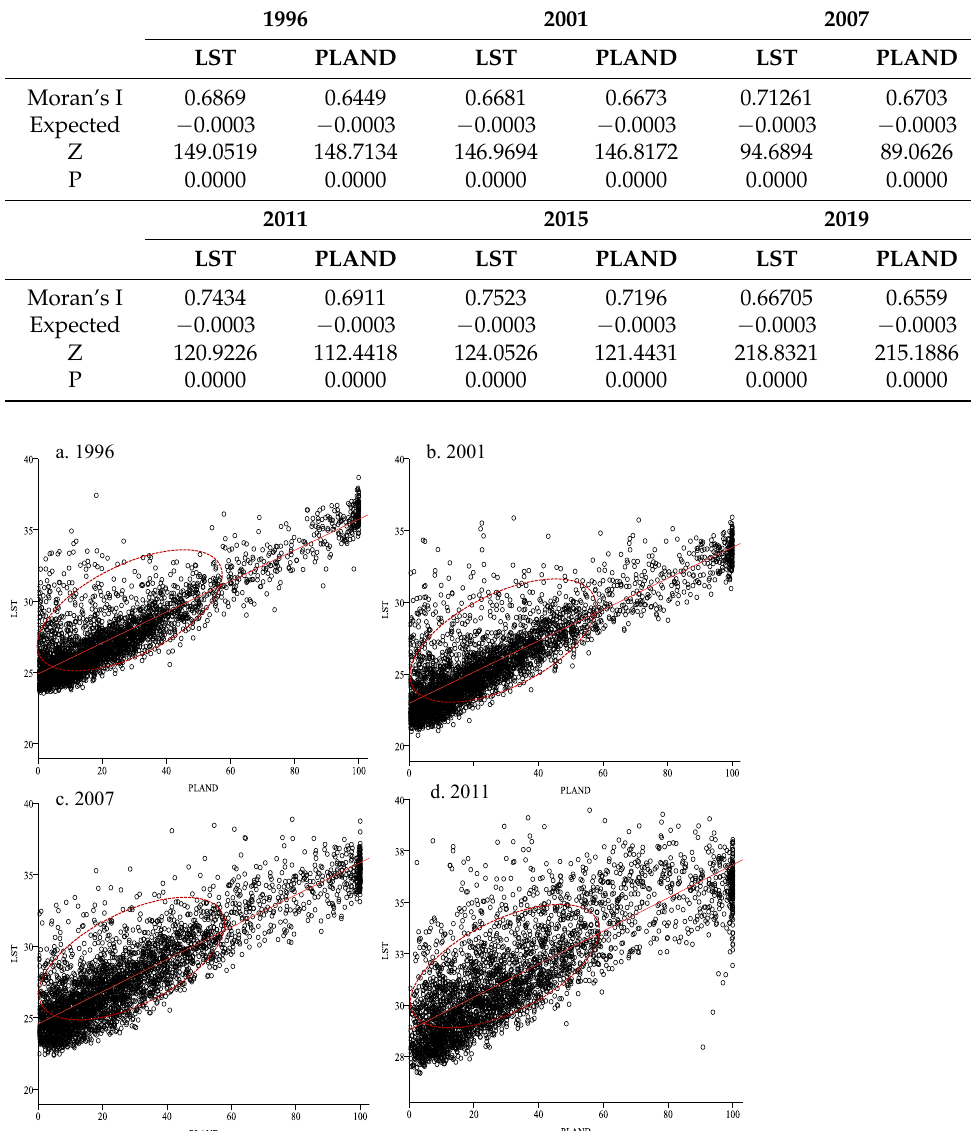
Table 3. Moran’s I of the percentage of built-up land (PLAND) and land surface temperature (LST) from 1996 to 2019.